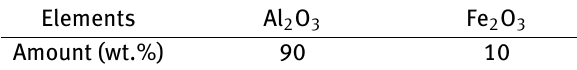
Table 2: Chemical compositions of MA. Elements